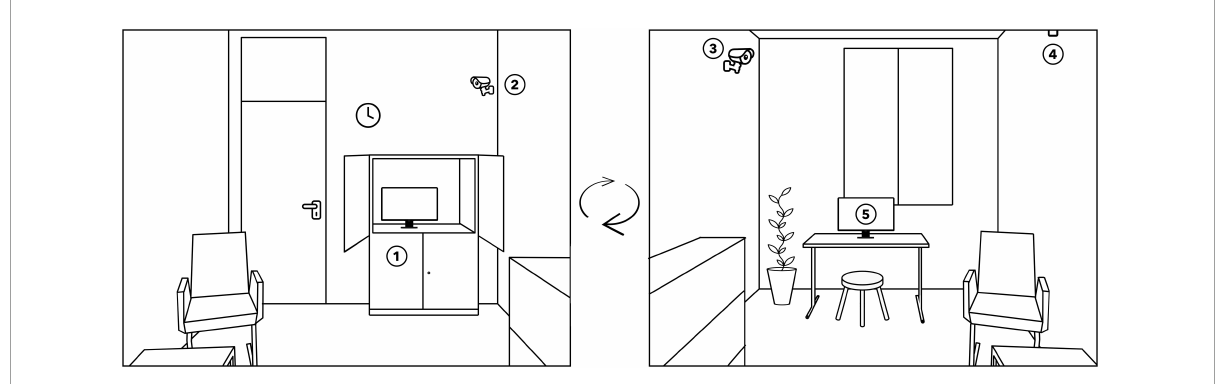
FIGURE2 Sketch of the structure of a therapy room from two different angles. 1 = video and audio recording equipment (hidden in a cupboard), 2 = camera that focuses on the therapist, 3 = camera that focuses on the patient, 4 = microphone, and 5 = touchscreen for assessment of the session